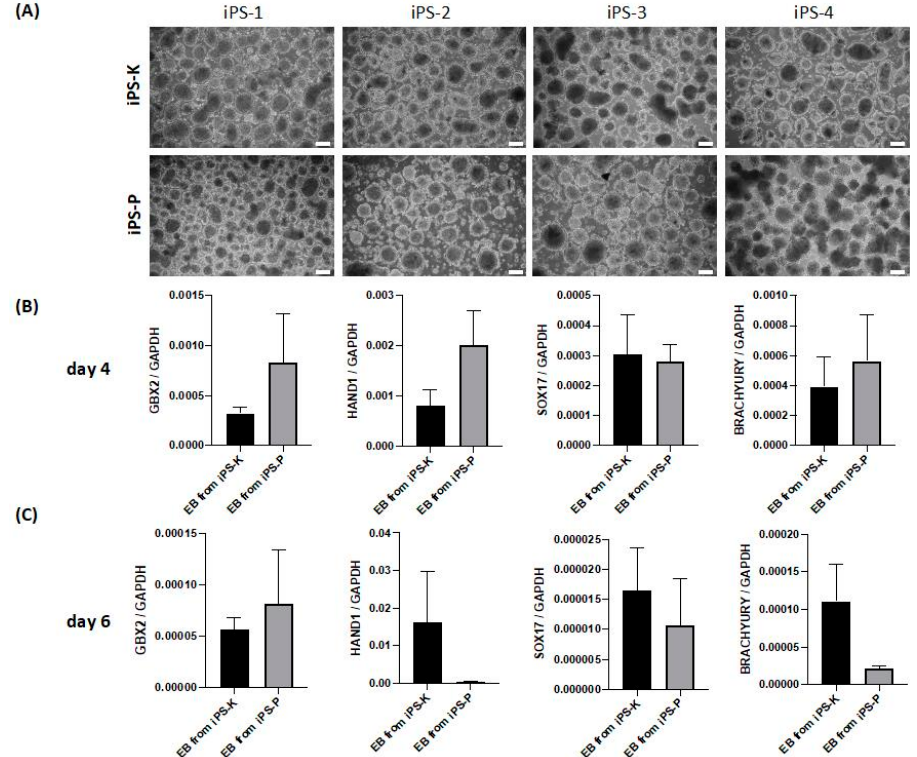
Figure 3. Formation of embryoid bodies from iPS cells. ( A ) Generated iPS cells formed embryoid bodies that displayed similar morphology (representative images). The photographs show representative images on day 4. White scale bars represent 200 µ m. ( B ) Analysis of mRNA expression levels of markers of three germ layers in embryoid bodies on day 4: GBX2—ectodermal marker; HAND1—marker of early trophoblast di ff erentiation; SOX17—endodermal marker; BRACHYURY—mesodermal marker. GAPDH was housekeeping gene control and the data were calculated using the ∆ Ct method. Significant di ff erences between embryoid bodies (EBs) of di ff erent origin were not observed. The graph data show the results from 4 clones in duplicates, collected on day 4 ( n = 8). The data represent the mean ± SEM. ( C ) Analysis of mRNA expression levels of markers of three germ layers in embryoid bodies on day 6. Significant di ff erences between EBs of di ff erent origin were not observed on day 6. The graph data show the results from 3 clones, collected on day 6 ( n = 3). The data represent the mean ±